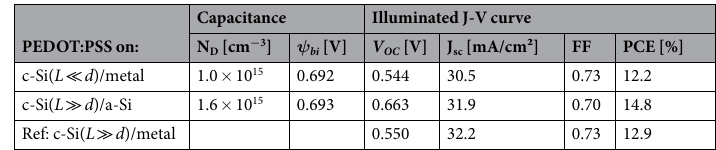
Table 1. Summary of the measured PEDOT:PSS/c-Si solar cell device parameters. The doping density N D of the c-Si wafers and the build-in voltage ψ bi in the device are derived from the C - V measurements in Fig. 2b.